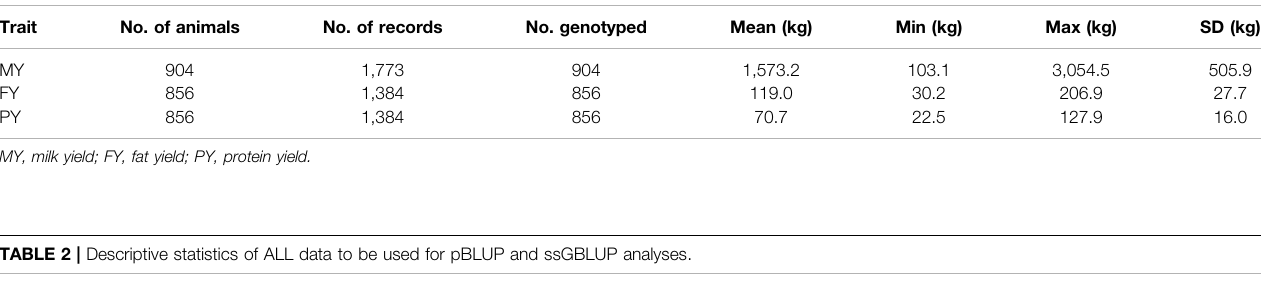
TABLE 1 | Descriptive statistics of GENO data to be used for pBLUP and GBLUP analyses. Trait No. of animals No. of records